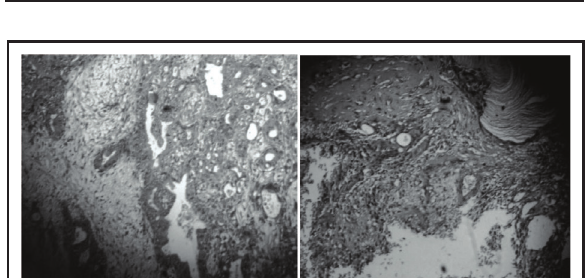
Figure 4. Microscopic section shows tumor composed of epithelial and myoepithelial cells forming tubules and sheets with fibromyxoid stroma. The cytoplasm with large,hyperchromatic